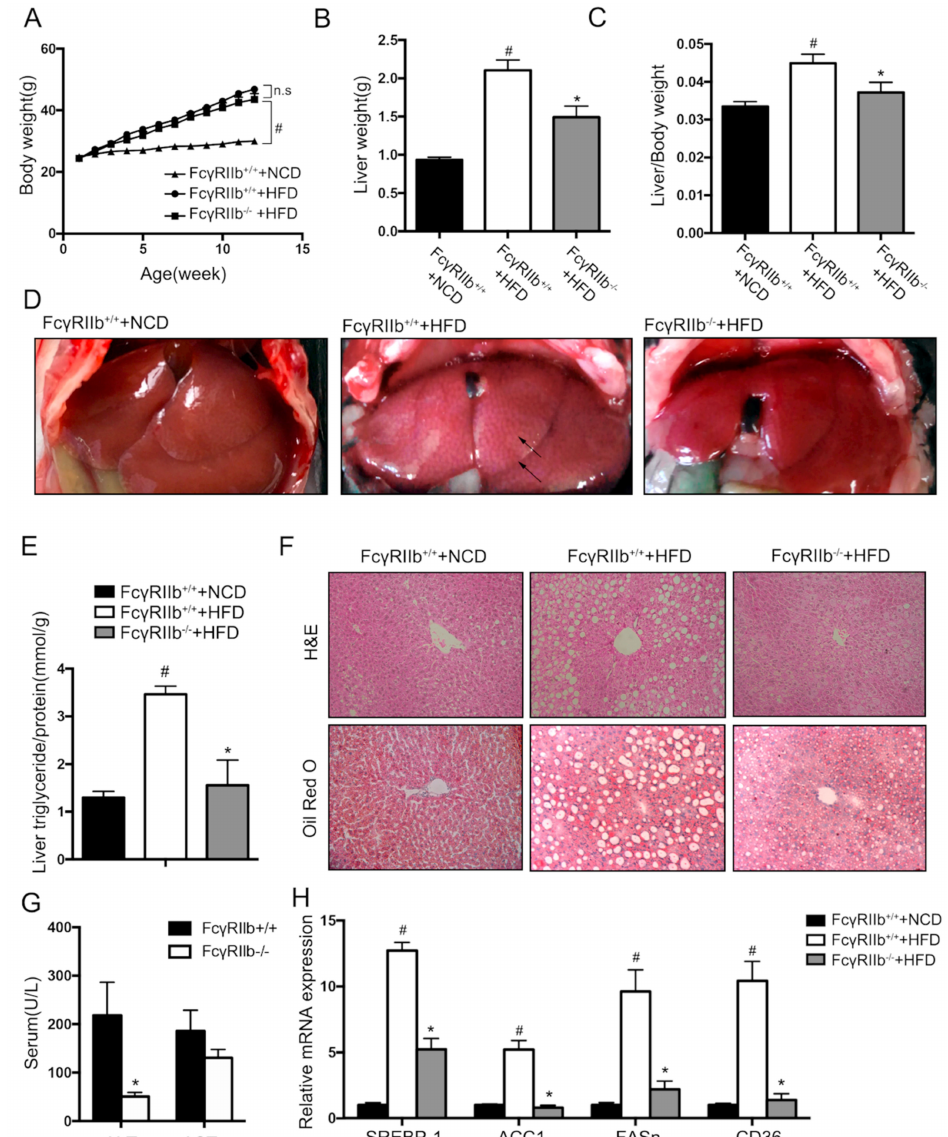
Figure 4. Effect of Fc γ RIIb knockdown on high fat diet (HFD)-induced hepatic steatosis. ( A ) Body weight gain in response to normal chow diet (NCD) and HFD for Fc γ RIIb +/+ mice, and HFD for Fc γ RIIb − / − mice ( n > 5/group). ( B ) Liver weight after 16 weeks of NCD and HFD feeding in Fc γ RIIb +/+ on NCD and HFD, Fc γ RIIb − / − mice on HFD ( n > 5/group). ( C ) Liver/body weight ratio of Fc γ RIIb +/+ on NCD and HFD, Fc γ RIIb − / − mice on HFD for 16 weeks ( n > 5/group). ( D ) Gross morphology changes in liver of Fc γ RIIb +/+ mice on NCD and HFD, Fc γ RIIb − / − mice on HFD for 16 weeks. Arrows indicate lipid droplets in liver. ( E ) Liver triglyceride content in Fc γ RIIb +/+ on NCD and HFD, Fc γ RIIb − / − on HFD for 16 weeks ( n > 3/group). ( F ) Representative H&E stained (top, 20 × ) and Oil Red O–stained (bottom,20x) images of liver sections from Fc γ RIIb +/+ mice on NCD and HFD, Fc γ RIIb − / − mice on HFD for 16 weeks. ( G ) ALT and AST levels in the serum of Fc γ RIIb +/+ and Fc γ RIIb − / − mice after 16 weeks of HFD ( n > 5/group). ( H ) qRT-PCR analysis of mRNA expression of SREBP-1 , ACC1 , FASn , and CD36 . Total RNA was isolated from Fc γ RIIb +/+ mice fed with NCD, and Fc γ RIIb +/+ or Fc γ RIIb − / − mice on HFD. The data shown are the means ± SEM. # p < 0.05, control mice (Fc γ RIIb +/+ ) of NCD vs. HFD; * p < 0.05, HFD feeding of Fc γ RIIb +/+ vs. Fc γ RIIb − / −